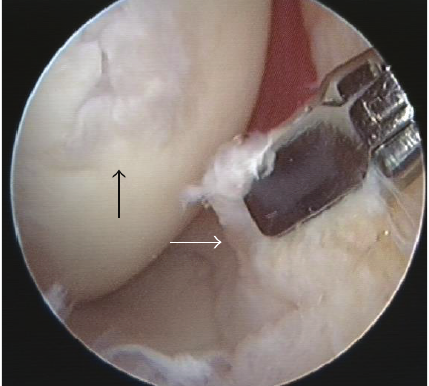
Figure 5: Focal nodular reactive changes adjacent to the focal cartilage defect (black arrow) in the absence of generalized synovitis ( white arrow